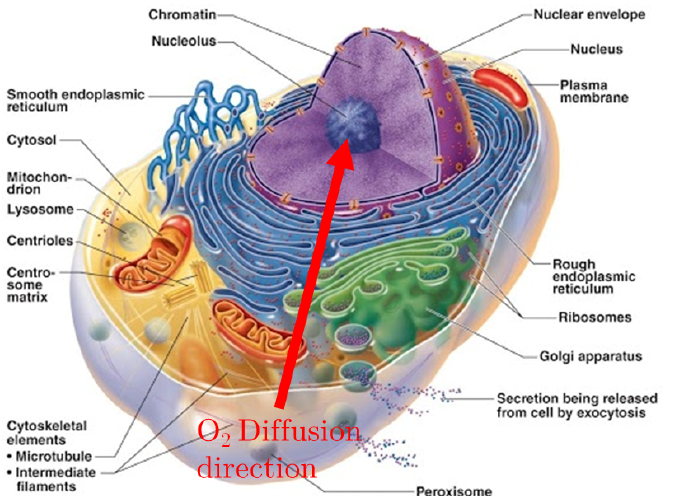
Figure 1. Section of the cell, showing the membrane’s development around the nucleus. The Red arrow shows the direction of Oxygen diffusion, from the extra-cellular matrix to the nucleus, crossing the ER membranes.